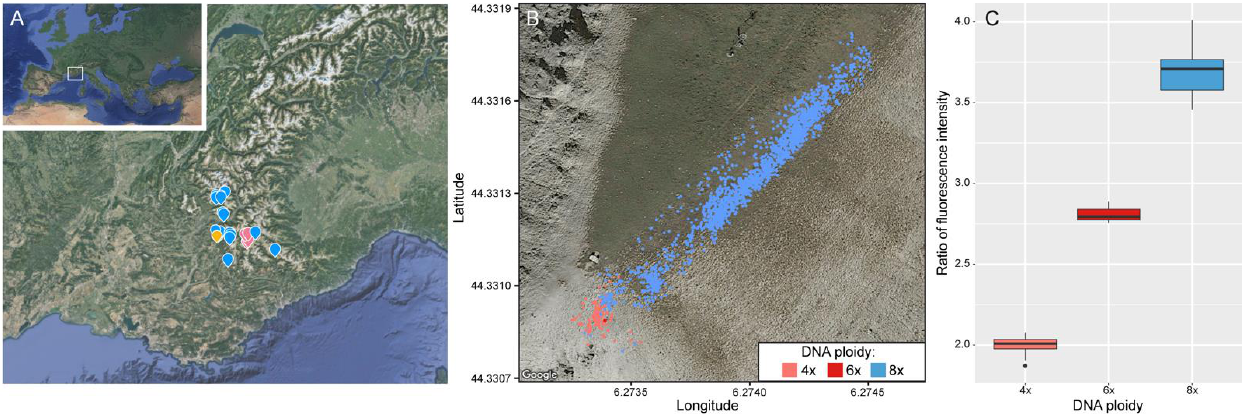
Figure 1. Habitat preferences and morphology of tetraploid ( A , B , C ) and octoploid ( D , E , F ) cytotypes observed in Senecio doronicum from the population of Tête Grosse (Alpes-de-Haute-Provence, France).